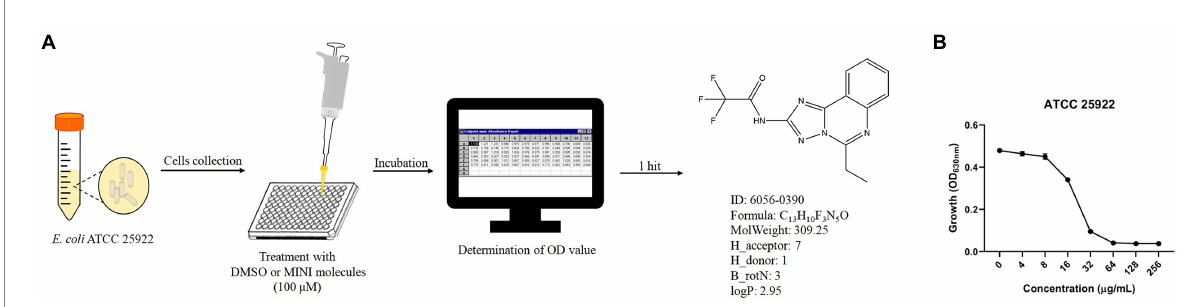
FIGURE 1 Antimicrobial effects of 0390 against Escherichia coli . (A) Workflow of the in vitro high-throughput screening assay of the MINI Scaffold library, containing 5,033 MINI molecules. The OD value was determined by a microplate spectrophotometer. The structural formula and characteristics of a hit (hit compound), 0390 (6056–0390) were shown. H_acceptor: hydrogen bond acceptor count. H_donor: hydrogen bond donor count. B_ rotN: rotatable bond count. LogP: oil- water partition coefficient. (B) Growth of E. coli ATCC 25922 after exposure to different concentrations of 0390 for 18 h. The experiment was repeated three